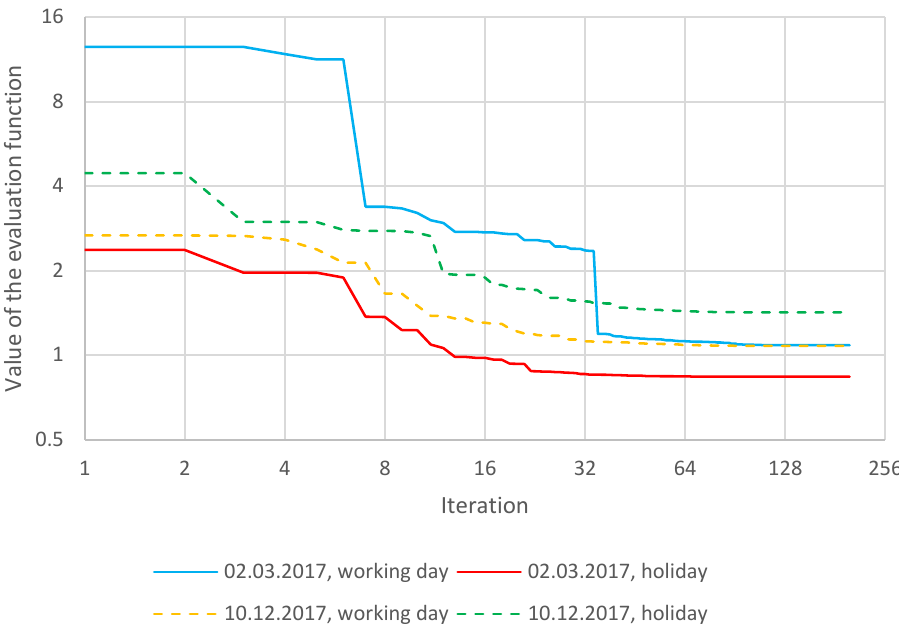
Figure 10. Progress of the optimization process.